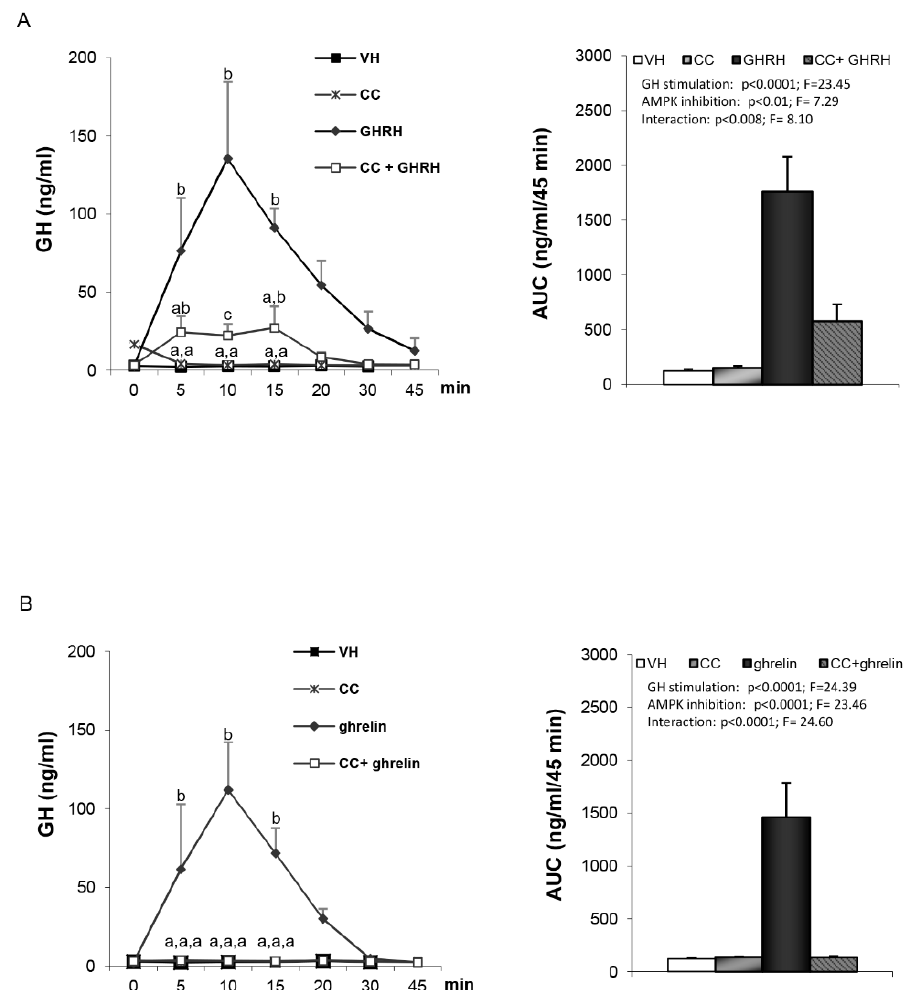
Figure 1. Serum growth hormone (GH) profile and area under the curve (AUC) over the study period (45 min) after administration of: ( A ) VH (5 µ L DMSO icv plus 200 µ L saline iv), CC (10 µ g compound C icv plus 200 µ L saline iv), growth hormone–releasing hormone (GHRH) (5 µ L DMSO icv plus 12 nmol / kg GHRH iv), CC + GHRH (10 µ g compound C plus 12 nmol / kg GHRH iv). ( B ) VH (5 µ L DMSO icv plus 200 µ L saline iv), CC (10 µ g compound C icv plus 200 µ L saline iv), ghrelin (5 µ L DMSO icv plus 12 nmol / kg ghrelin iv) or CC + ghrelin (10 µ g compound C icv plus 12 nmol / kg ghrelin iv).